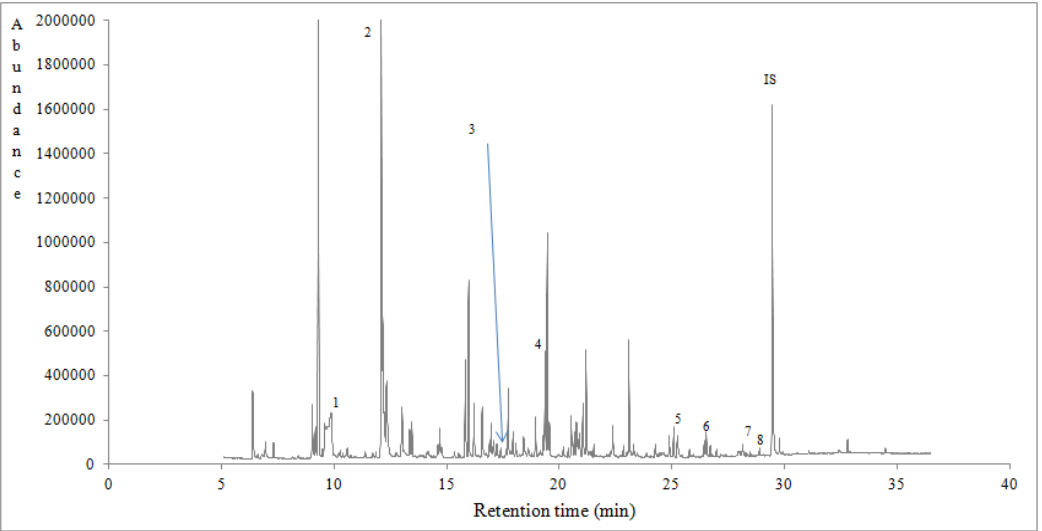
Figure 1. A typical gas chromatogram of eucalyptus honey from the region of Viseu, Oliveira de Frades in Portugal. 1: 2-Butanone. 2: Octane. 3: alpha-Phellandrene. 4: Linalool. 5: 2-Buten-1-one. 6: 2,6-bis-(1,1-trimethyl)-2,5-cyclohexadiene-1,4-dione. 7: alpha-Calacarene. 8: Byciclo [5.3.0] decapentaene. IS: Internal